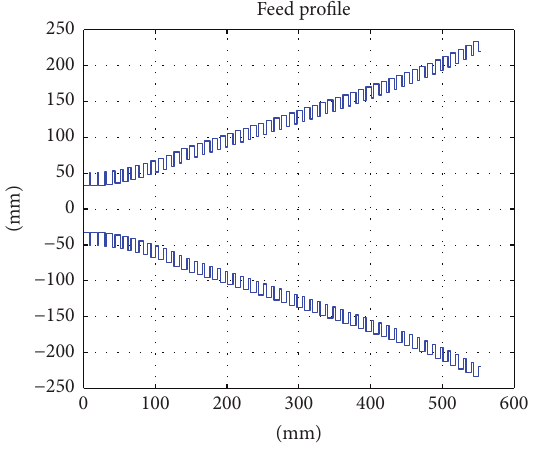
Figure 6: Profile of the final horn.